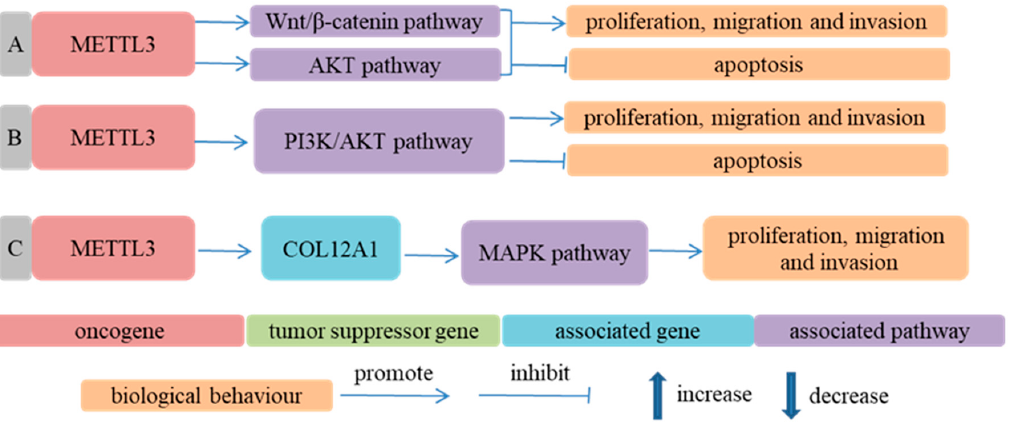
Figure 4. Methyltransferases participate in ESCA progression in an m 6 A-independent way. ( A ) Ref. [124] METTL3 promoted proliferation, migration and invasion of ESCC cells and suppressed apoptosis of ESCC cells by activating Wnt/ β -catenin and AKT signaling pathways; ( B ) Ref. [126] METTL3 facilitated proliferation, migration and invasion of ESCC cells and repressed apoptosis of ESCC cells by activating PI3K/AKT signaling pathway; ( C ) Ref. [127] METTL3 increased COL12A1 expression, activated MAPK signaling pathway and promoted proliferation, migration and invasion of ESCC cells.